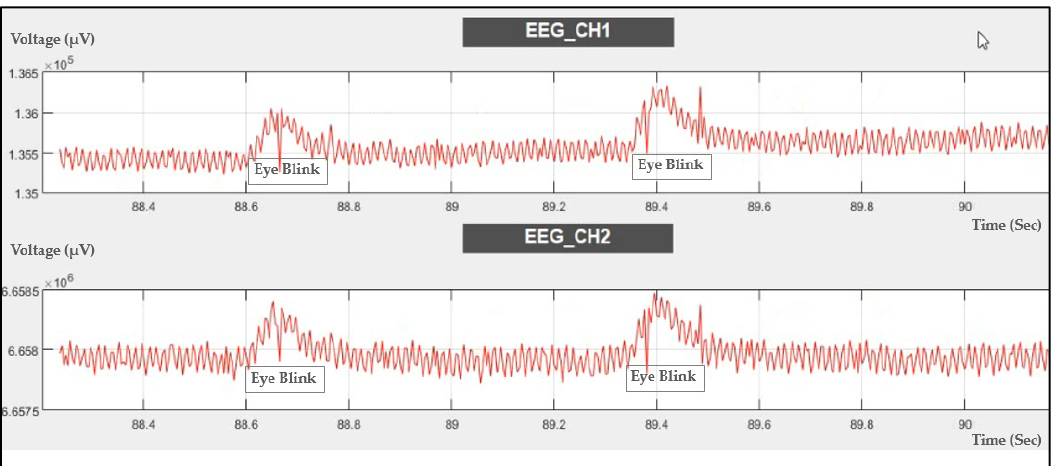
Figure 14. Two-channel EEG data recorded during eye blinking.